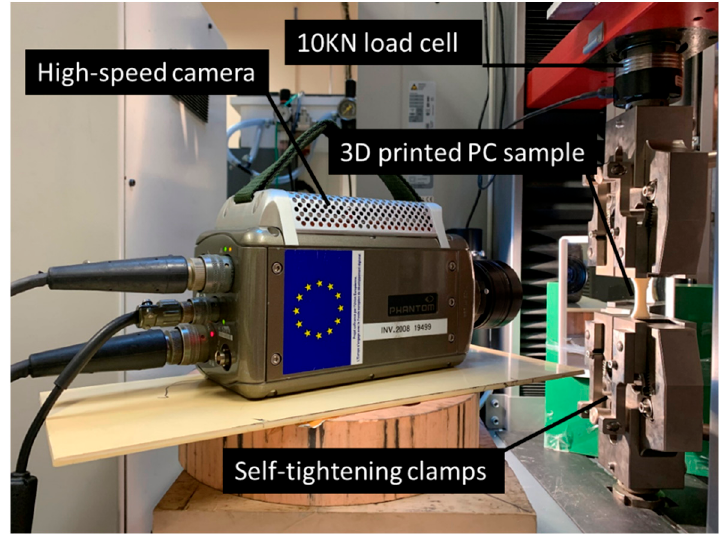
Figure 3. Mechanical testing setup.